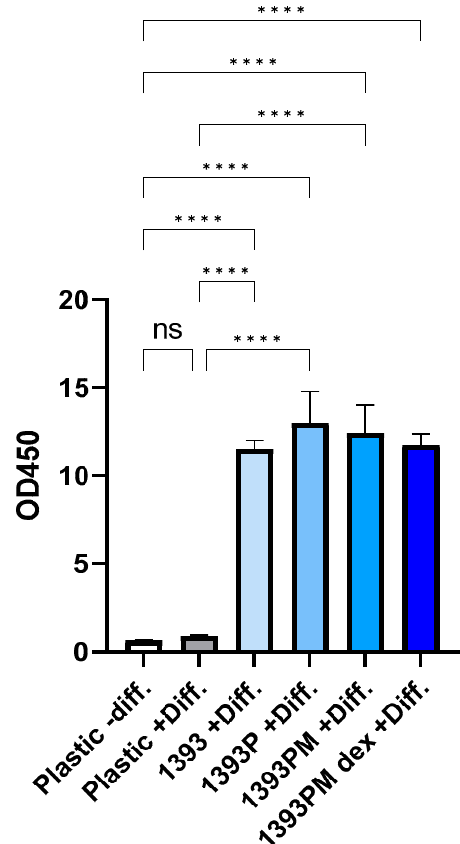
Figure 14. Evaluation of deposition of inorganic calcium salts as osteogenic marker in hAMSCs cultured onto the biomaterials. Quantification of ARS at day 21 was performed by measuring the OD spectrophotometrically at 450 nm. The OD of scaffolds seeded with hAMSCs was calculated after removing the OD of scaffolds subjected to ARS without containing cells. The number of replicates per condition is three; ANOVA test corrected using the Tukey test for multiple comparisons, **** p < 0.0001.